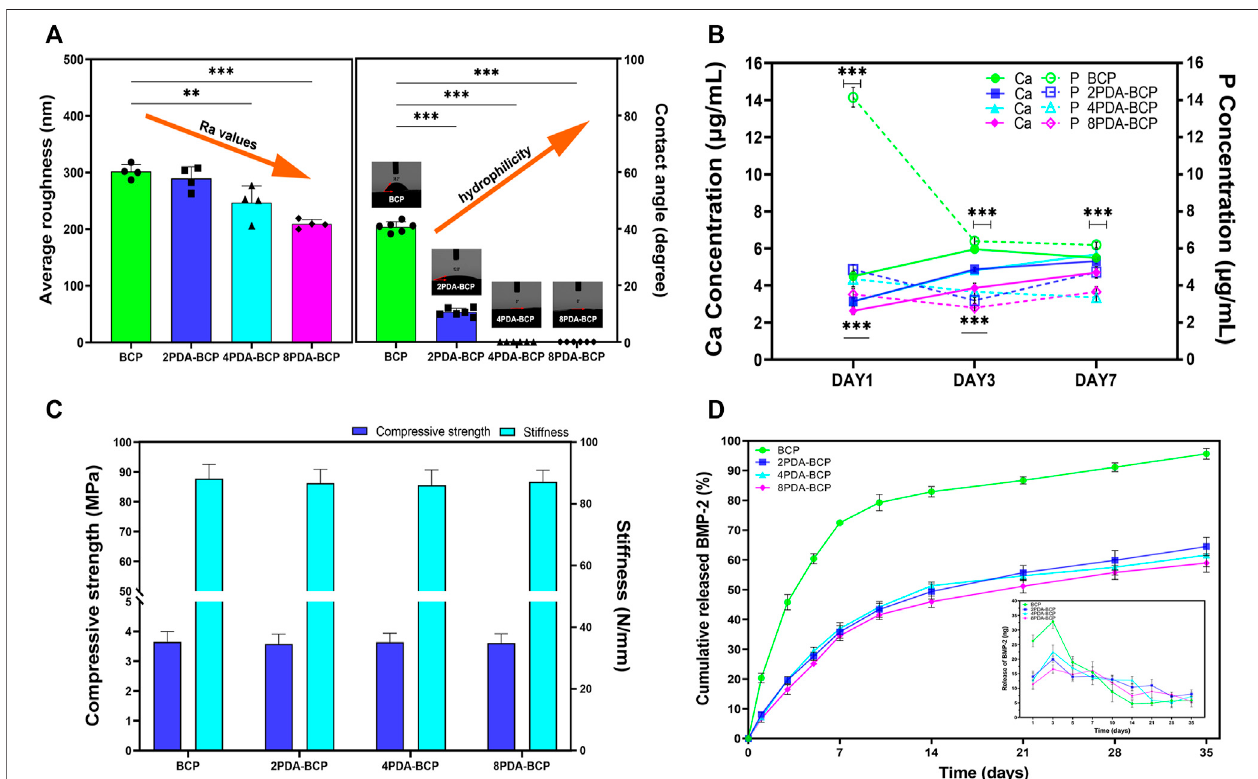
FIGURE 3 | Characterization of BCP and PDA-BCP scaffolds. (A) The statistical analysis of average roughness and water contact angle for BCP, 2PDA-BCP, 4PDA-BCP,8PDA-BCP scaffolds, respectively. ** p < 0.01, *** p < 0.001. (B) The changeofCa and Pionic concentrationfrom various scaffoldsin theTris – HCl solutions (pH7.4),dataarepresented asthemean±S.D.*** p < 0.001. (C) Compressivestrength and stiffnessofscaffolds. (D) CumulativeBMP-2release kineticsfromtheBCP, 2PDA-BCP, 4PDA-BCP, and 8PDA-BCP scaffolds, the insert graph shows the release number of scaffolds in each time